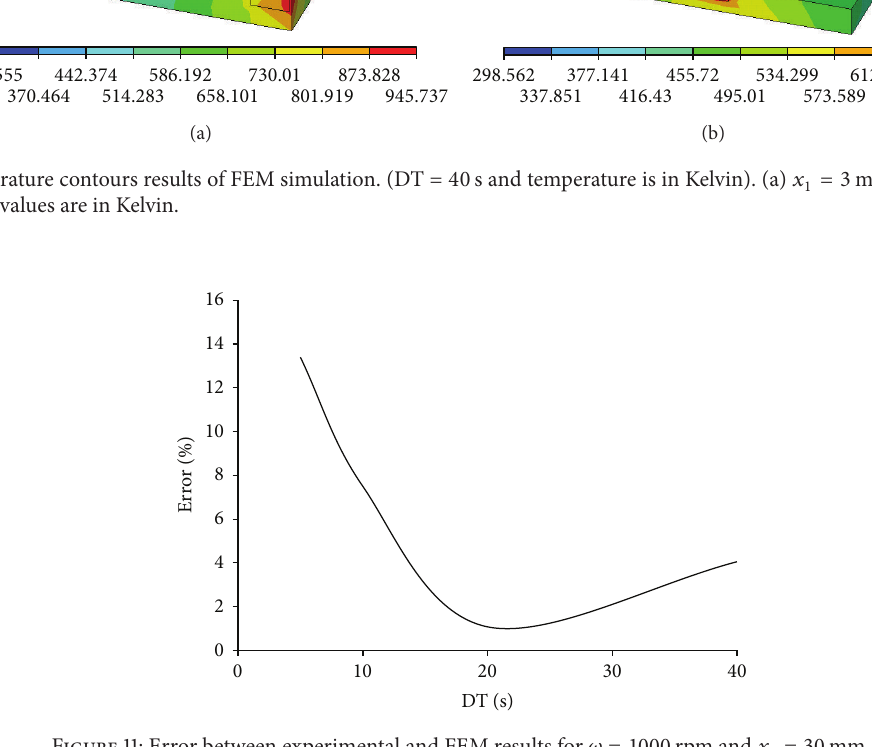
Figure 11: Error between experimental and FEM results for 𝜔 = 1000 rpm and 𝑥 1 = 30